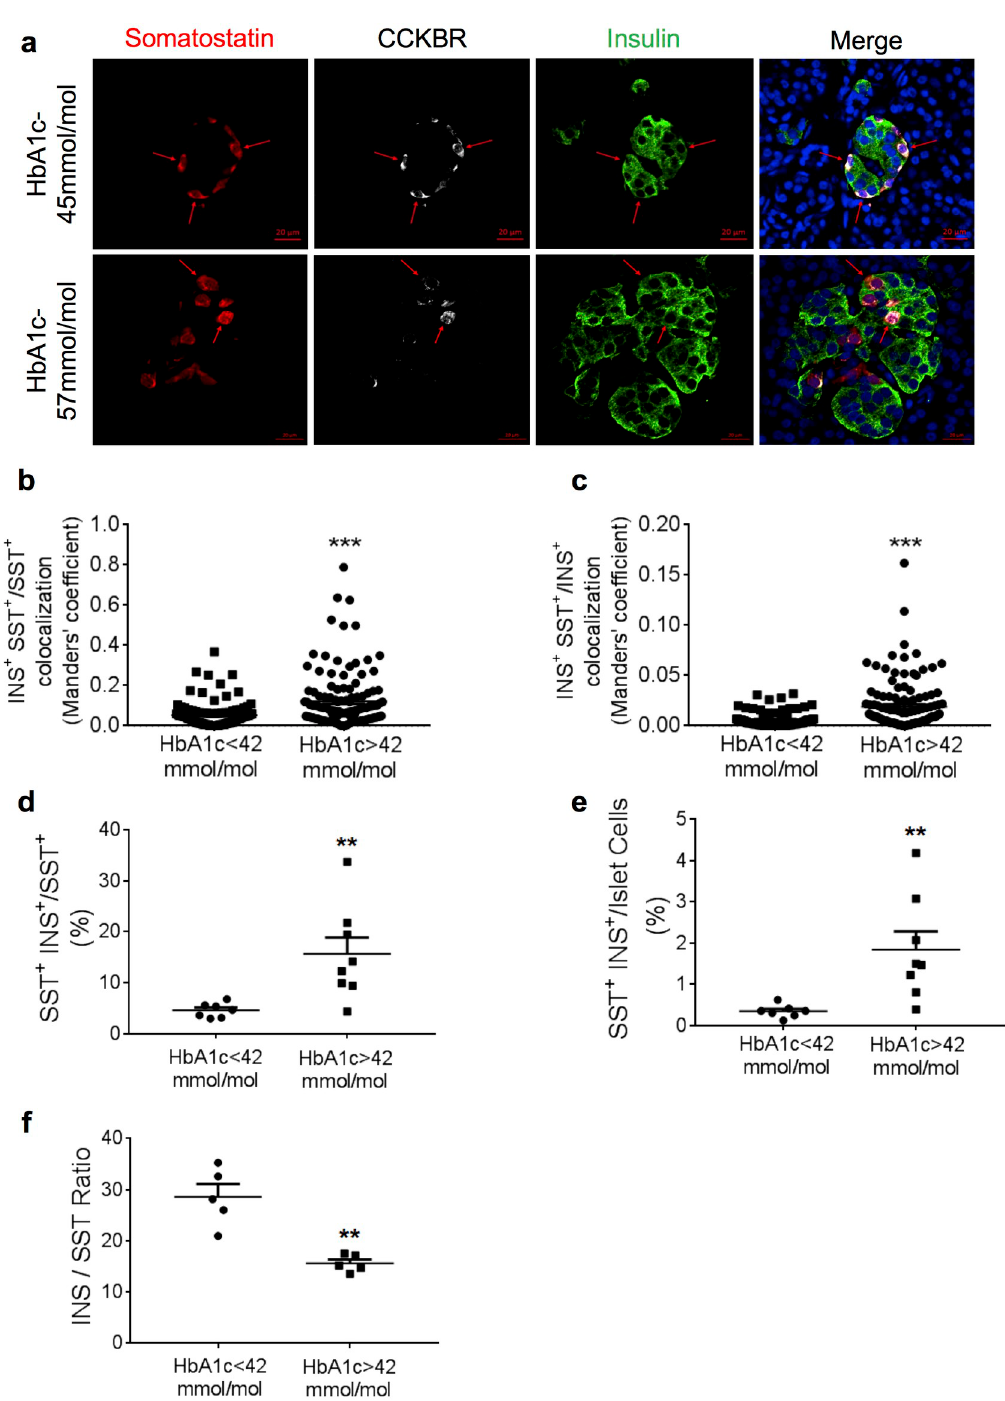
Fig 5. Cells simultaneously expressing insulin, somatostatin and CCKBR are more frequenly found in islets of donors with higher ( > 42 mmol/mol) HbA 1c . a. Formalin-fixed, paraffin-embedded tissue sections of adult human pancreases were examined by triple immunofluorescence staining. Shown are examples of islet cells from donors with higher HbA 1c levels co- expressing insulin (green), somatostatin (red) and CCKBR (white). DNA was stained blue with DAPI. b. ratio of double- positive pixels for insulin and somatostatin over the sum of insulin-positive pixels. c. ratio of double positive pixels over the sum of somatostatin positive pixels. d. Percentage of insulin -positive cells among somatostatin -expressing cells is increased in islets of donors with higher HbA 1c . Based on counting 102–400 delta-cells per donor. e. Percentage of cells expressing both insulin and somatostatin among the total number of islet cells is increased in islets of donors with higher HbA 1c . Based on counting 1016–4022 cells per donor. f. Ratio between insulin positive area and somatostatin positive area was decreased in islets